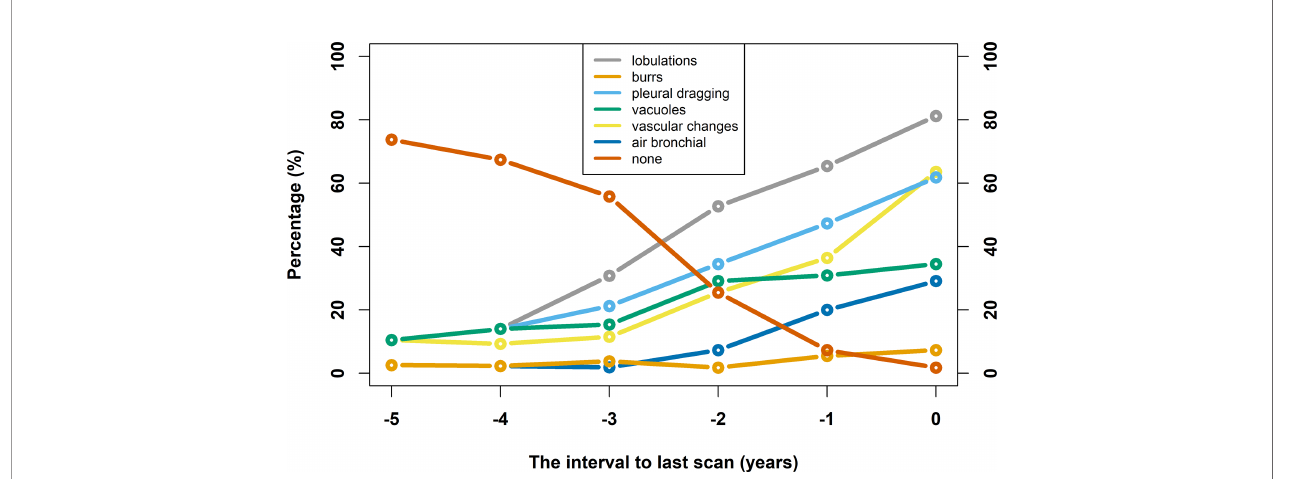
FIGURE 6 | Line chart of nodule poor morphological signs changes over time. The horizontal axis takes the time of con fi rmed diagnosis as zero, and the rest of the time is de fi ned relative to the time of con fi rmed diagnosis. The vertical axis indicates the percentage of poor morphological